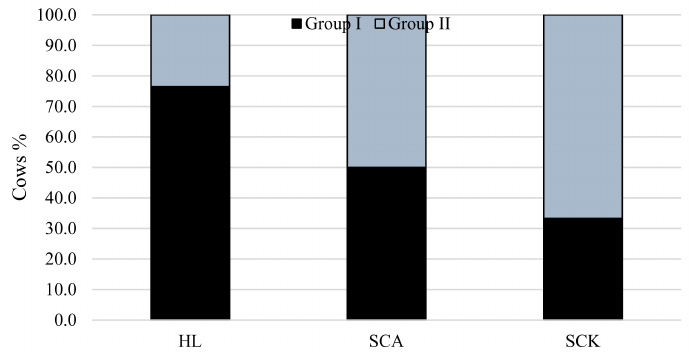
Figure 3. Relationship of NEFA level with the prevalence of SCA and SCK in cows. χ 2 = 41.9, df = 2, p < 0.001. HL: healthy cows; SCA: subclinical acidosis; SCK: subclinical